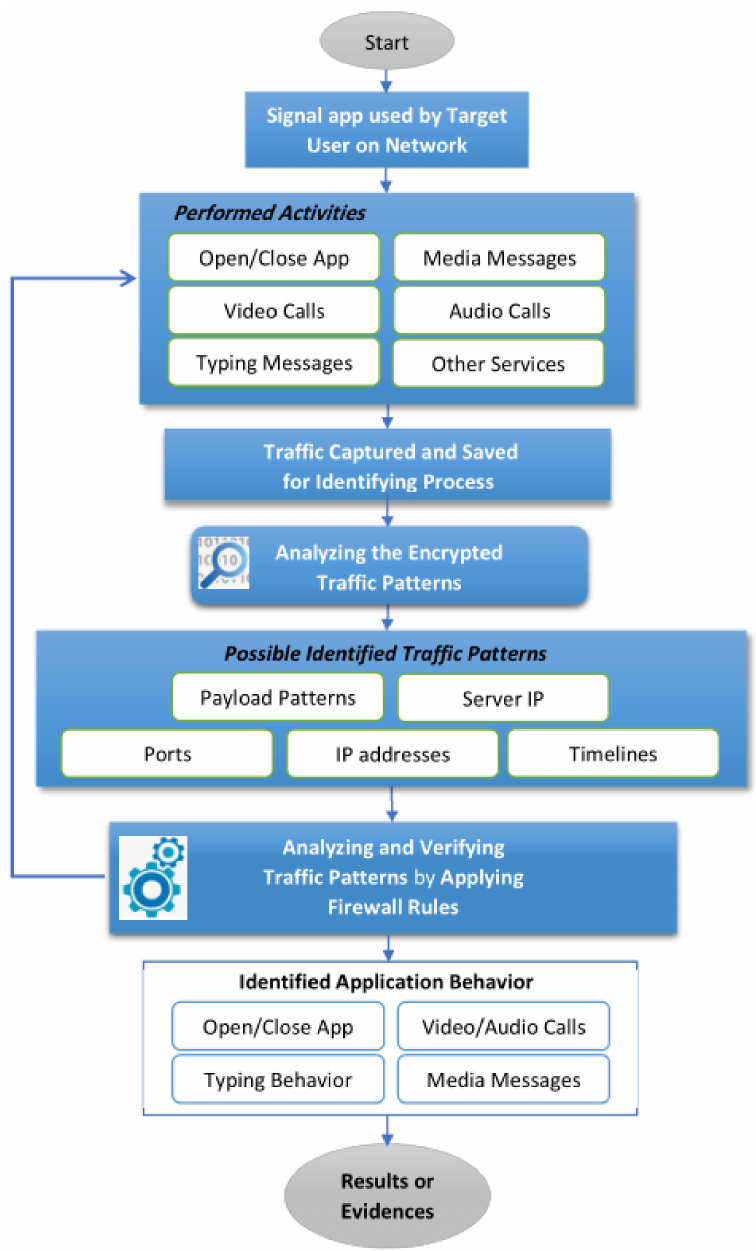
Figure 1. The flow diagram of proposed